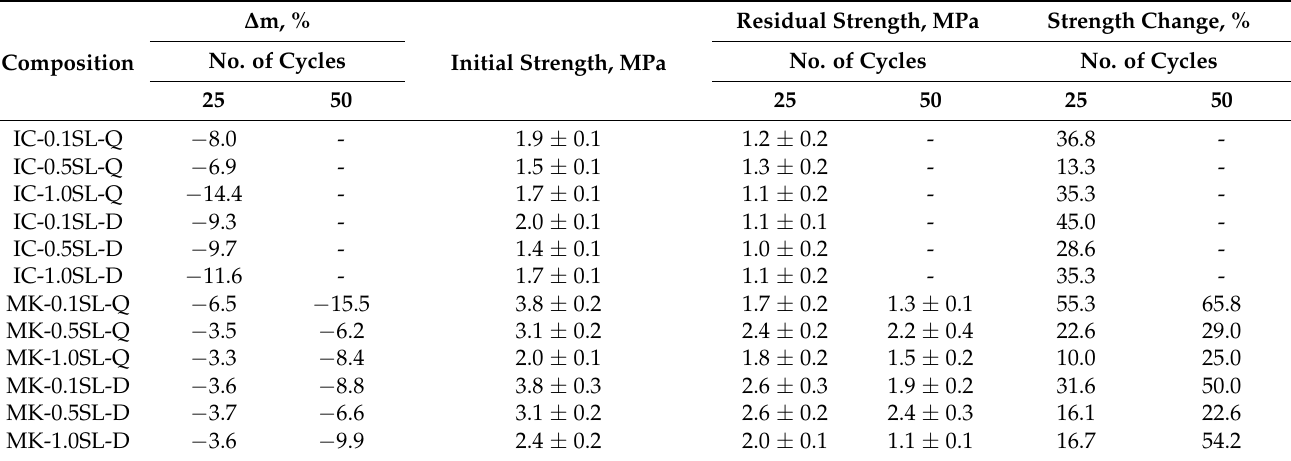
Table 4. Freeze-thaw resistance of porous geopolymers based on IC and